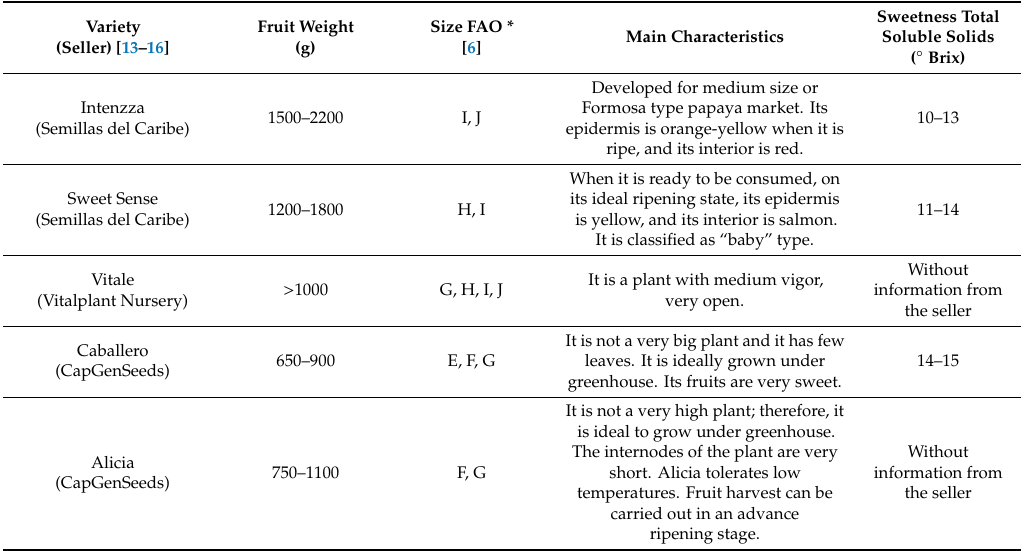
Table 1. Characteristics of the five cultivars of papaya, planted in this experiment, under